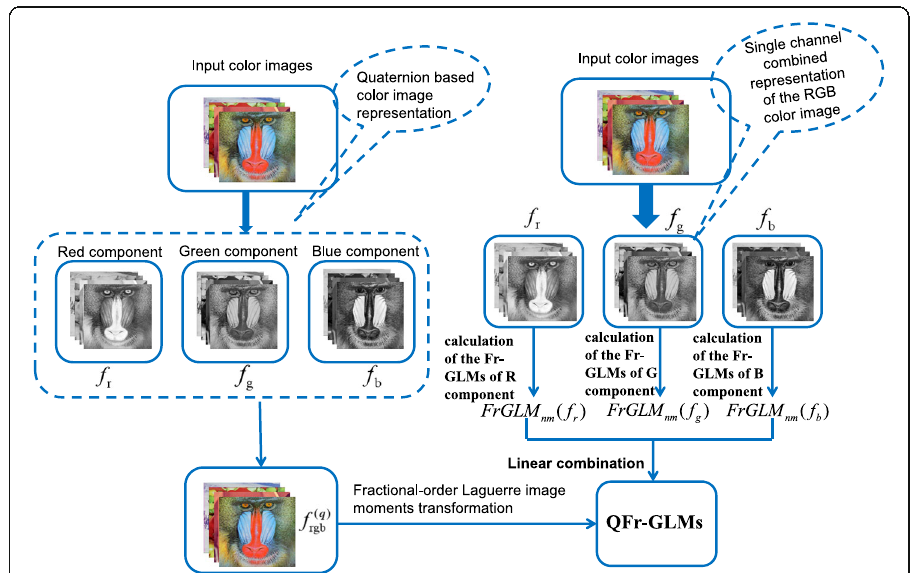
Fig. 1 Block diagram of QFr-GLM and single-channel Fr-GLM